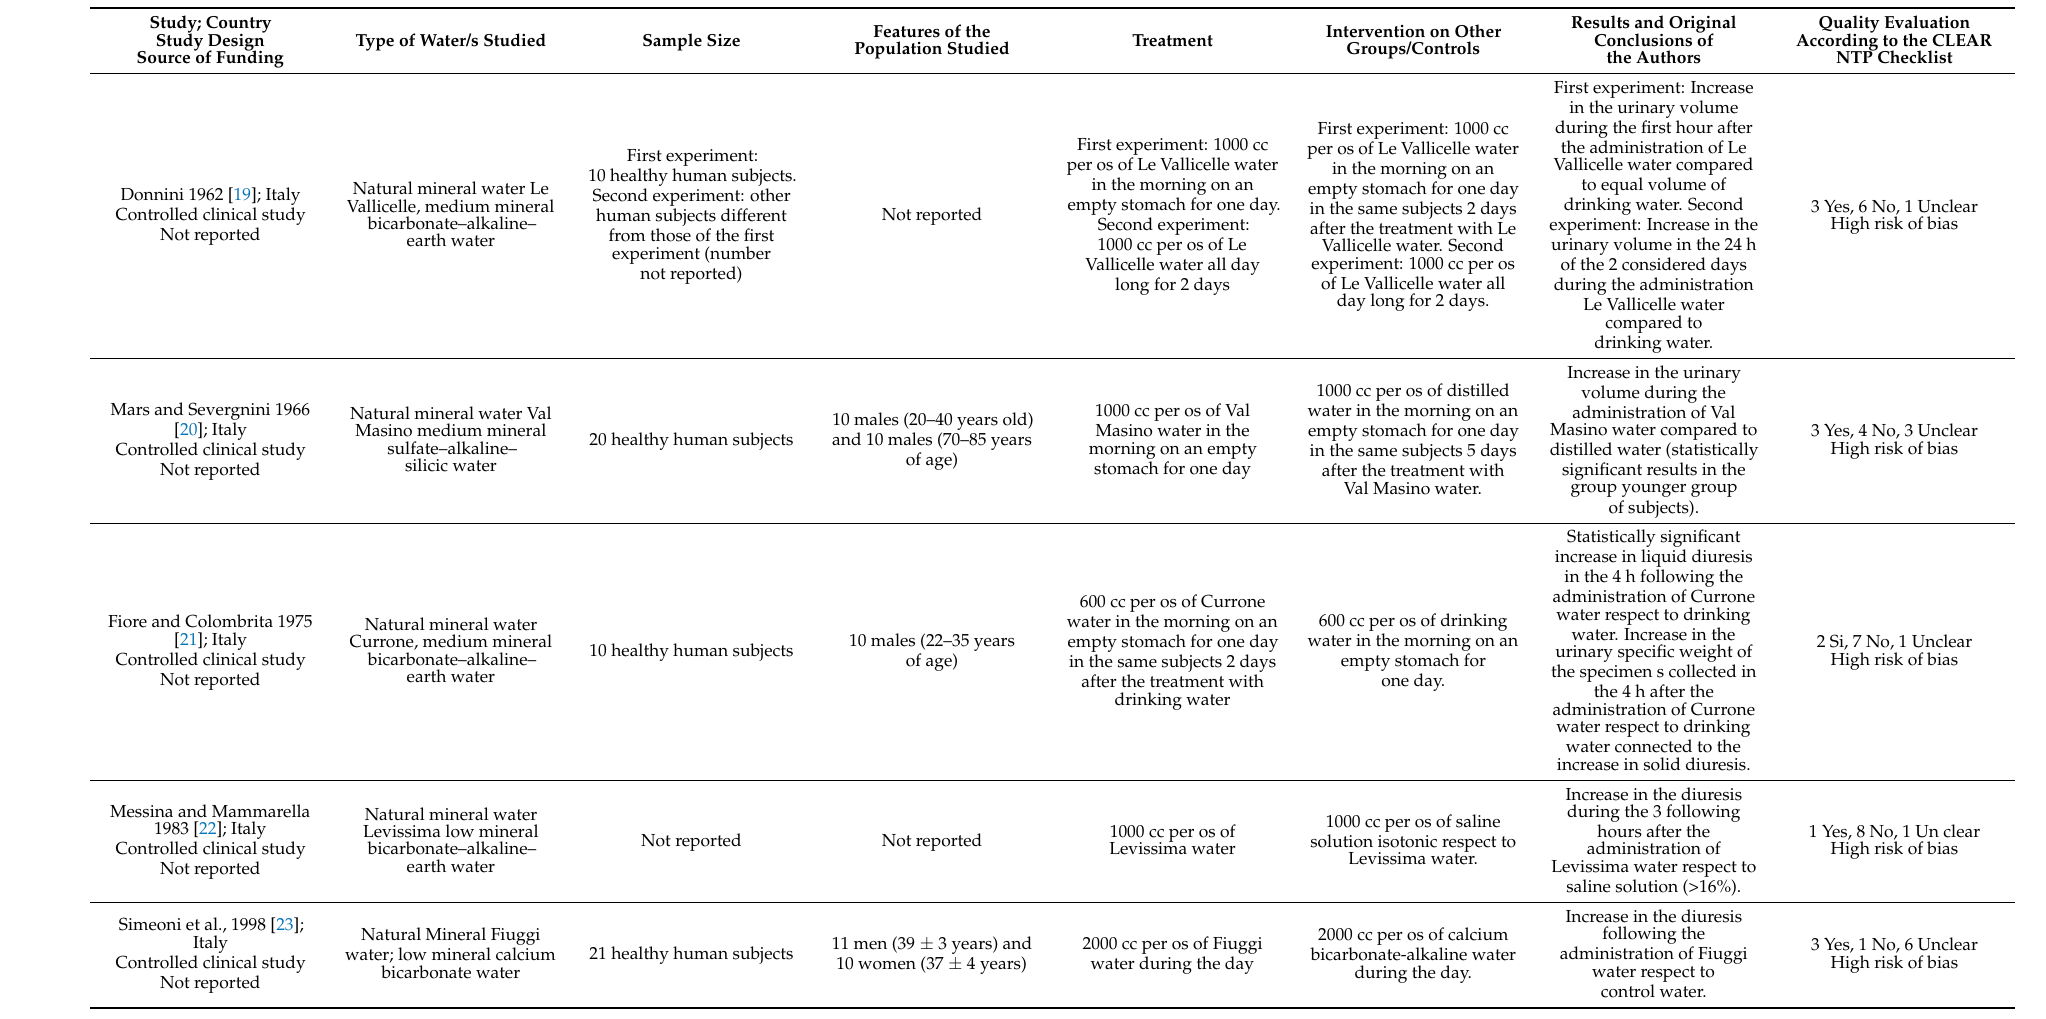
Table 1. Features of studies on human subjects included in the systematic